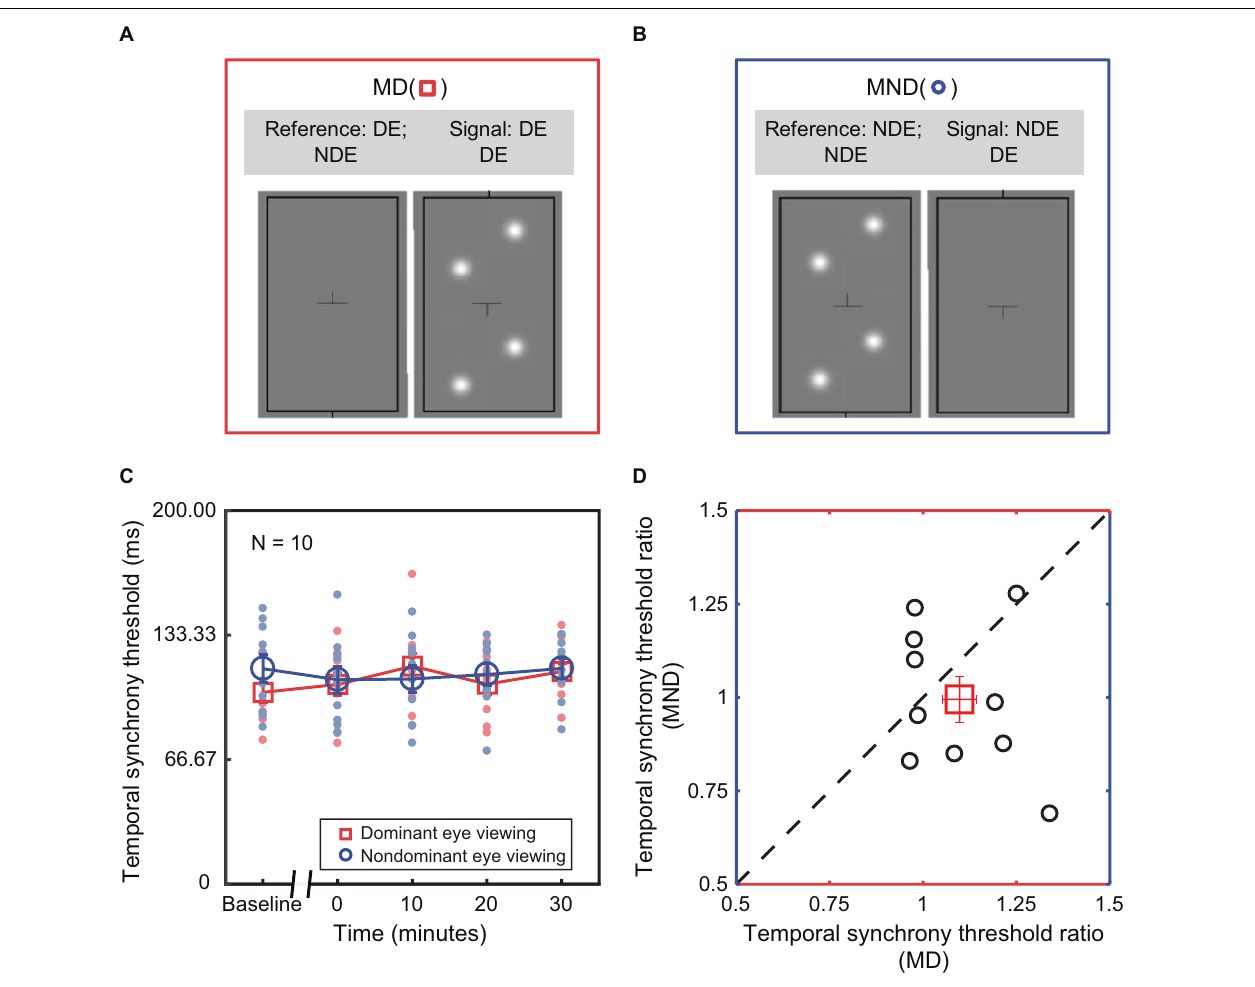
FIGURE 3 | Deprivation effect under monocular viewing configurations. (A) Monocular dominant eye viewing (MD). Both signal and reference blobs were presented to the dominant eye (i.e., the assigned patched eye). (B) Monocular non-dominant eye viewing (MND). Both signal and reference blobs were presented to the non-dominant eye (i.e., the assigned unpatched eye). (C) Monocular temporal synchrony threshold in the function of various time points before and after deprivation. The red plot corresponds to MD configurations, and blue plot to MND. Each dot (blue or red) represents the threshold of each subject. Open symbols (blue circle or red square) denote the average threshold across ten subjects. Error bars (blue or red) represent standard errors. (D) Correlation between the changes of monocular temporal synchrony in the deprived eye and non-deprived eye. Error bars represent standard error.